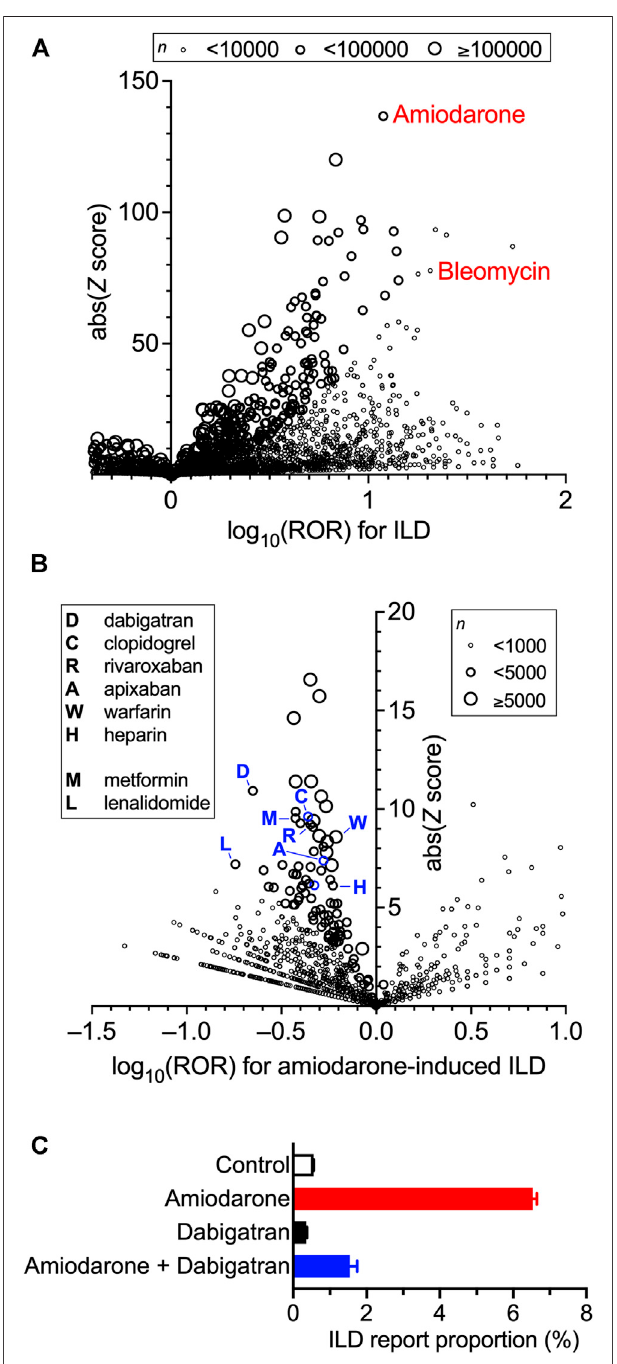
FIGURE 1 | Increased incidence of interstitial lung disease (ILD) with the prescription of drugs and confounding effects of concomitant drugs on amiodarone-induced ILD in the FDA Adverse Event Reporting System (FAERS) data. Volcano plots for visualizing the reporting odds ratio (ROR, on a log scale) and its statistical signi fi cance (absolute Z score) are shown. Each circle indicatesanindividualdrug,andthesizeofthecirclere fl ectsthenumberofpatients takingthedrug. (A) ,Strongandsigni fi cantincreasesintheRORforILDwereseen in patients using amiodarone and bleomycin. Overall values are presented in Supplementary Table S1 . (B) , Within the population taking amiodarone, ( Continued )